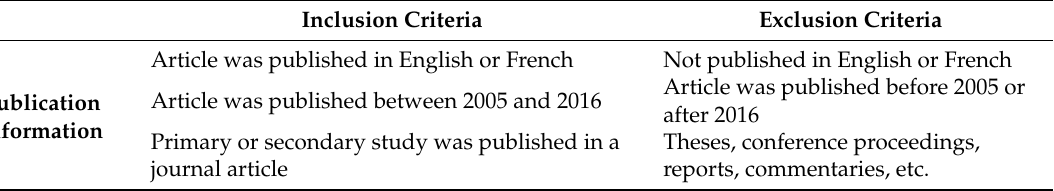
Table 2. Inclusion and exclusion criteria that were used in first-stage title and abstract screening and the second-stage full-text review to identify articles about integrated environment and health surveillance systems in Arctic and Subarctic regions of the Circumpolar North between 2005 and